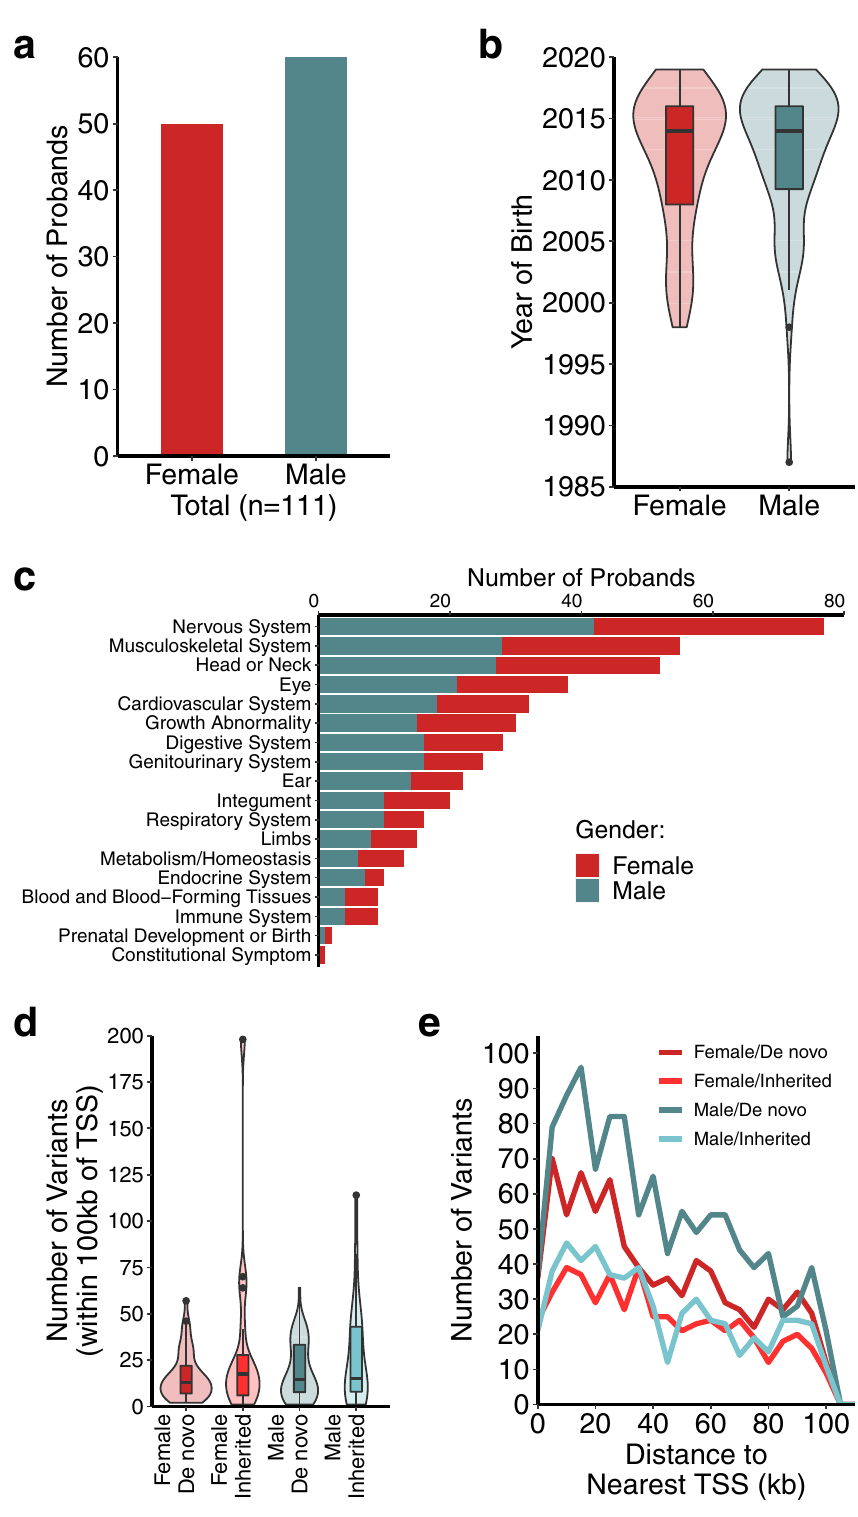
Figure 1. Identification of rare genetic variants from an undiagnosed rare disease cohort. ( a ) Gender composition of proband cohort. ( b ) Age distribution of proband cohort. ( c ) Prevalence of clinical features associated with selected patients. ( d ) Frequency of rare variants detected within 100 kb of a TSS. ( e ) Distance to nearest TSS for detected rare